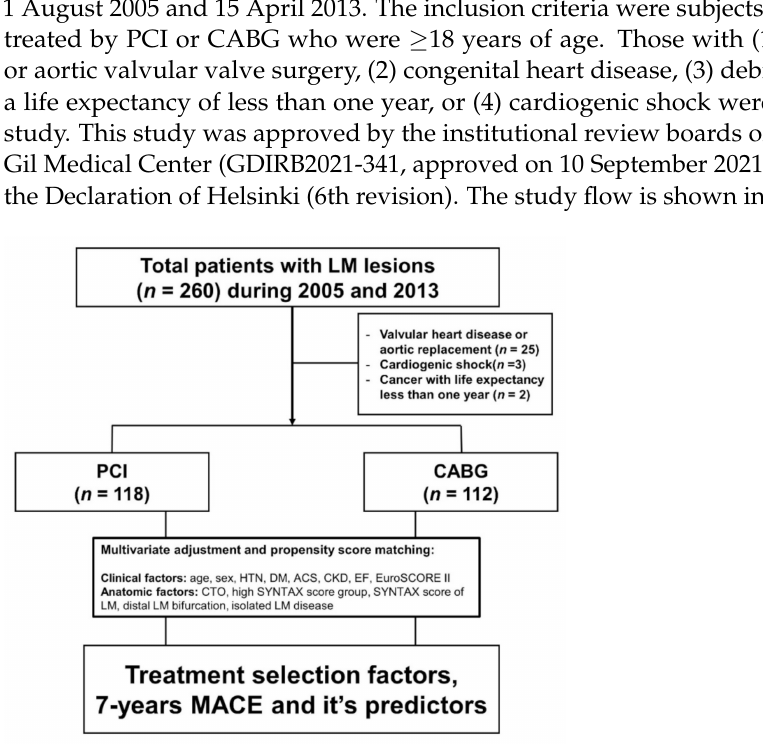
Figure 1. Study flow of enrolled patients. LM, left main; PCI, percutaneous coronary intervention; CABG, coronary artery bypass graft; HTN, hypertension; DM, diabetes mellitus; ACS, acute coro- nary syndrome; CKD, chronic kidney disease; EF, ejection fraction; CTO, chronic total obstruction; SYNTAX, SYNergy between percutaneous intervention with TAXus DES and cardiac